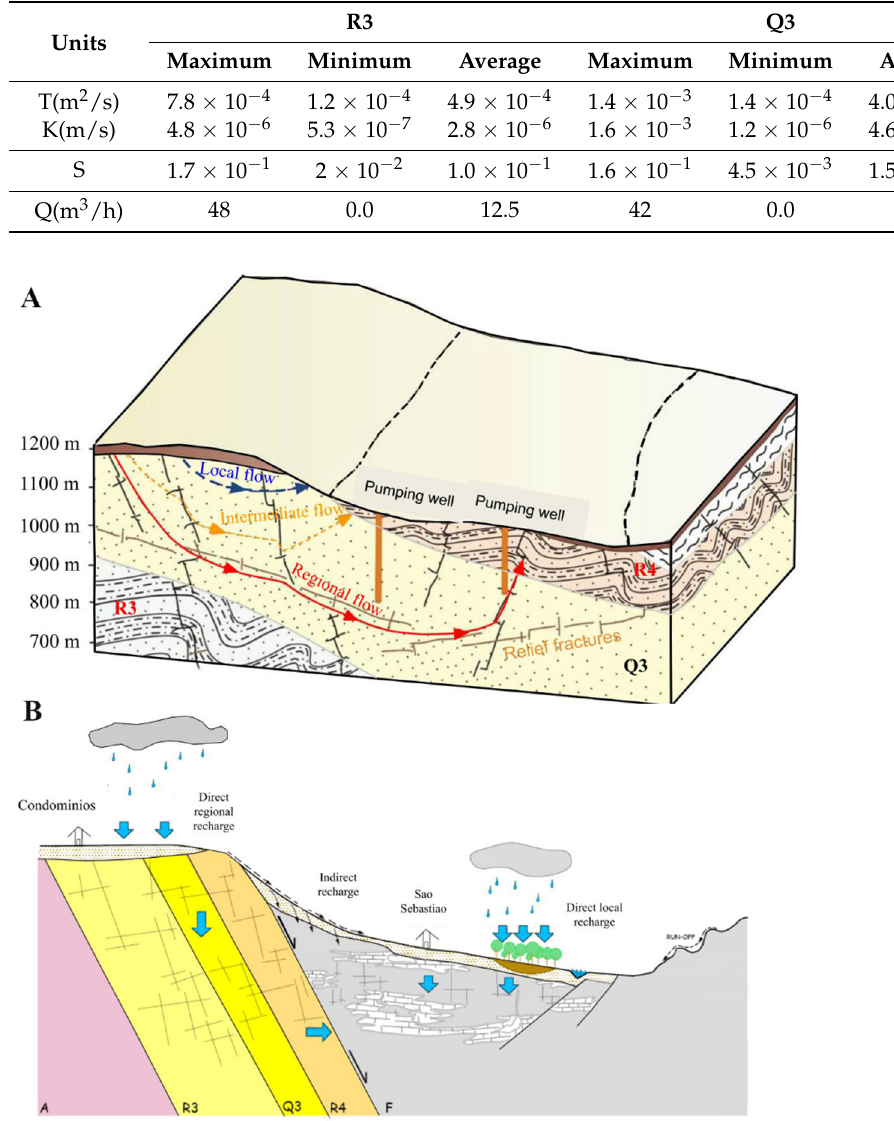
Figure 3. Conceptual groundwater flow model ( A ) recharge mechanism ( B ) of the aquifer sub-sys- tems (A, R3, Q3, R4, F) of Brasilia. (A, R3, Q3, R4, F) of